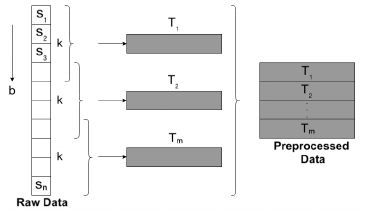
Figure 3. Data transformation to 1D